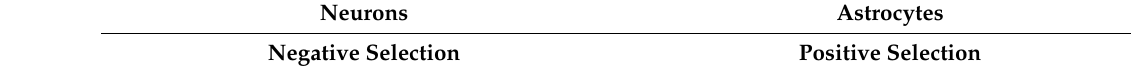
Table 2. Cont. Neurons Astrocytes Negative Selection Positive